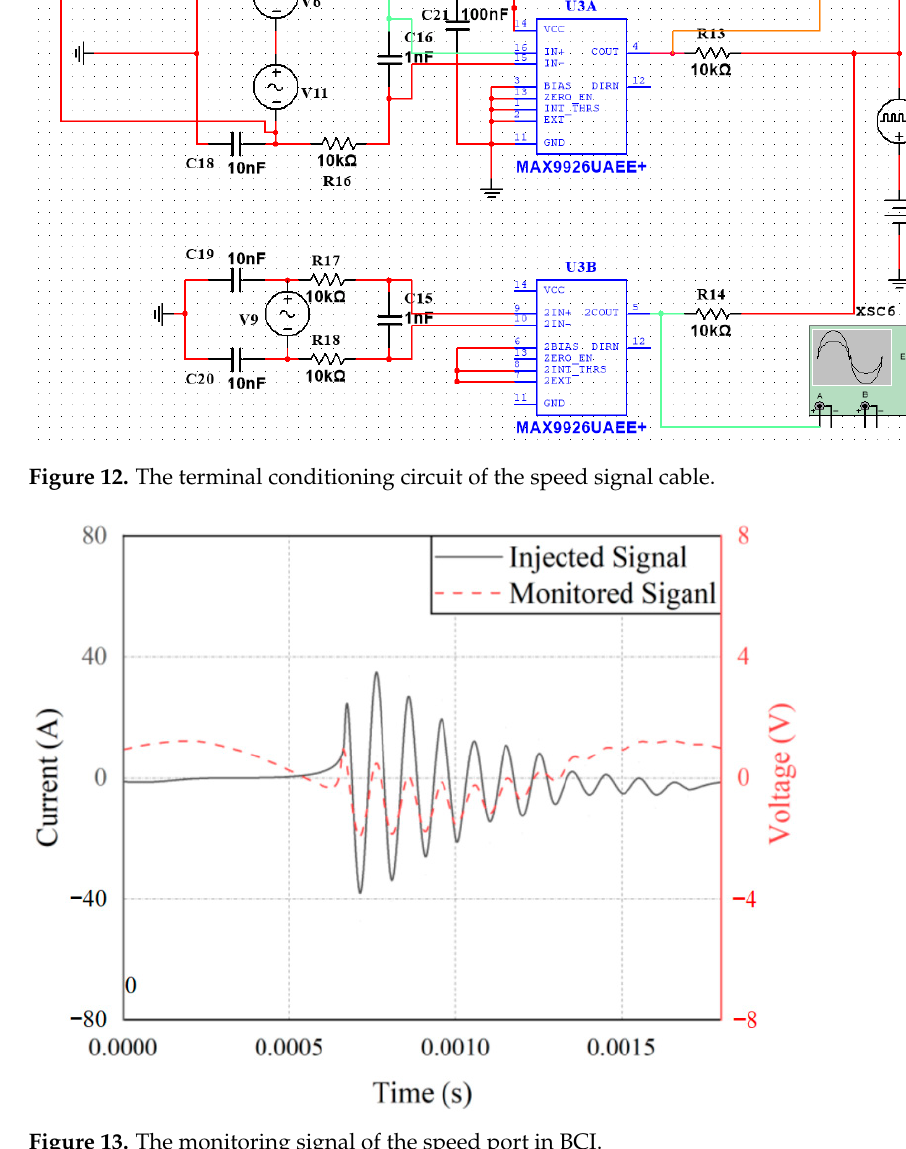
Figure 13. The monitoring signal of the speed port in BCI.